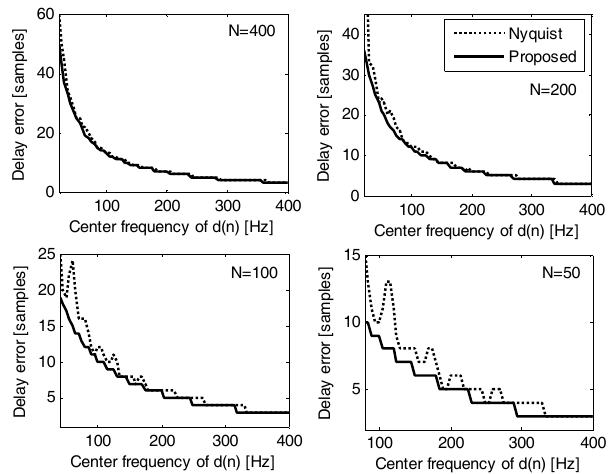
Figure 6. Comparison of stability bounds obtained by Nyquist criterion (dotted line) and the proposed Equation (23) (solid line).